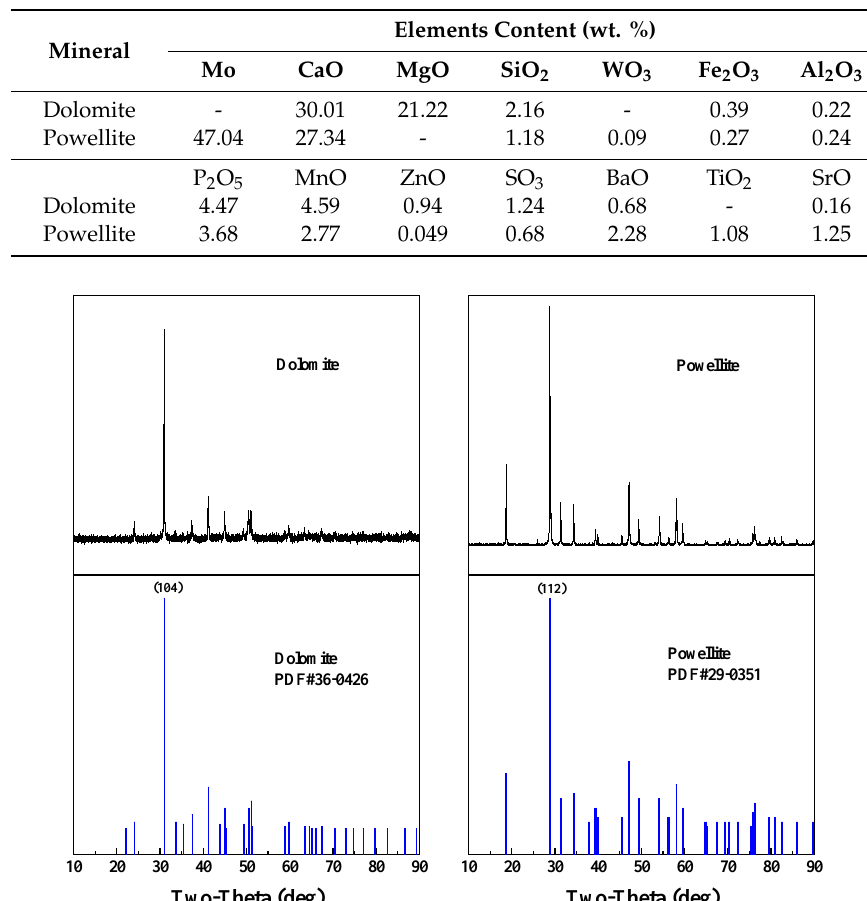
Table 1. Chemical analysis results of dolomite and powellite used in the experiments. Mineral